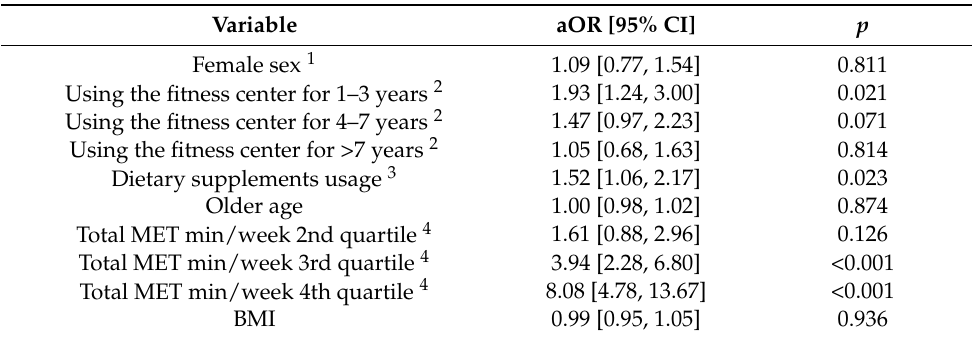
Table 5. Multivariable logistic regression analysis of the independent predictors for positive adher- ence to the MD according to the total MDSS